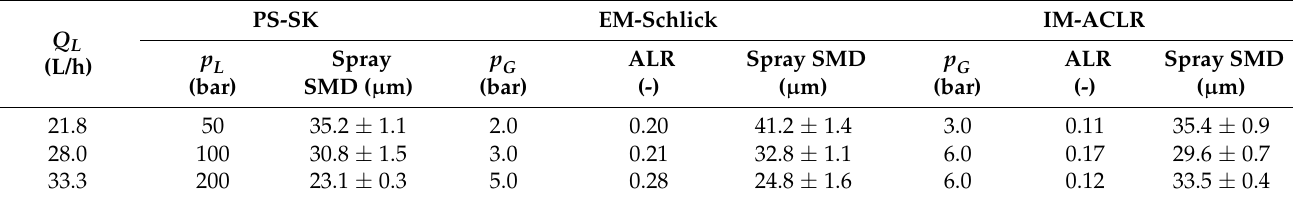
Table 1. Process conditions for the different atomizers at which oil droplet breakup is compared and their associated spray SMD. PS-SK: pressure swirl atomizer; EM-Schlick: external mixing twin-fluid atomizer; IM-ACLR: internal mixing twin-fluid